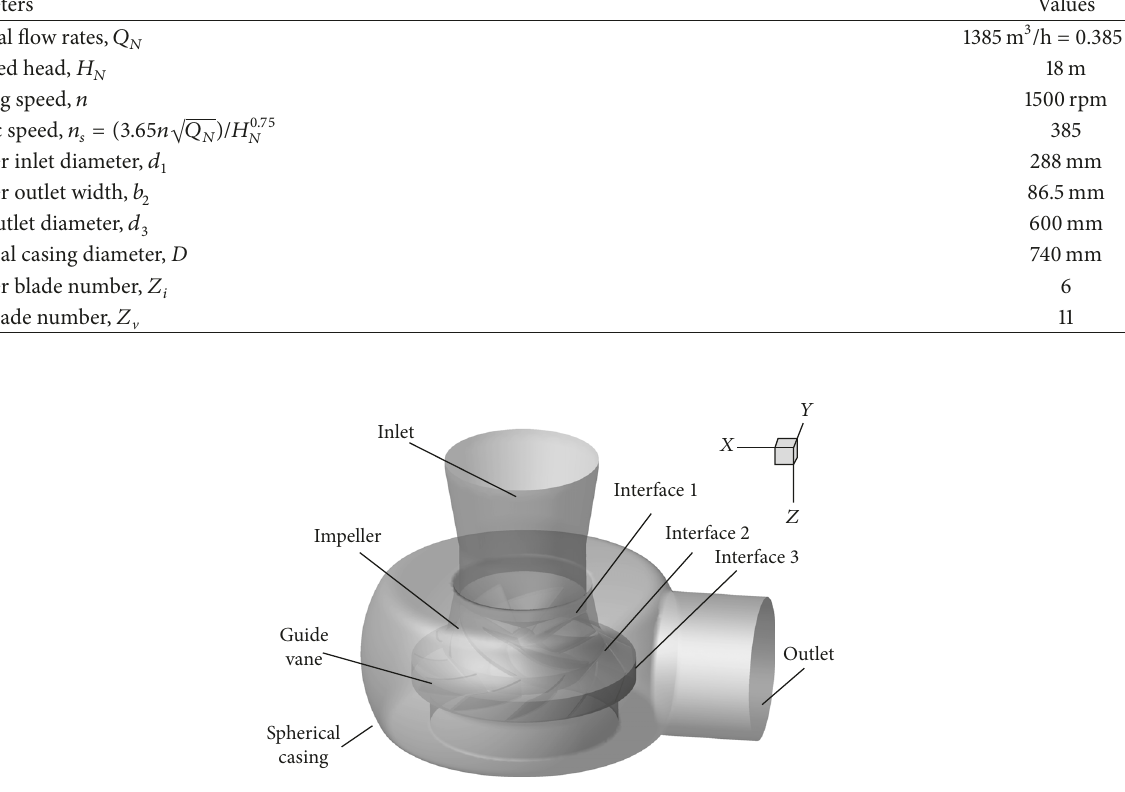
Figure 1: Three-dimensional